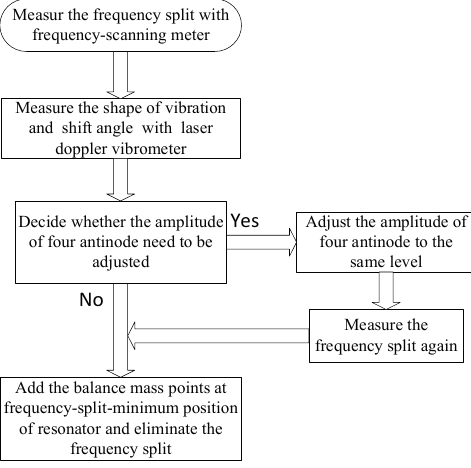
Figure 13. The instrument connection flow chart for natural frequency measurements.